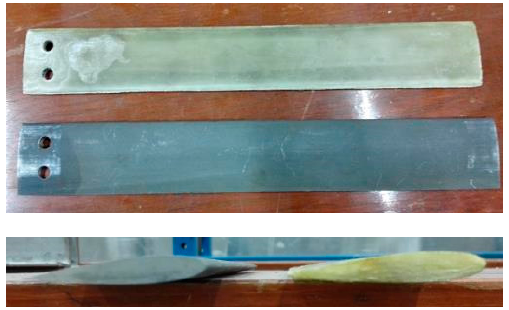
Figure 4. Geometry of rotor blade, including different materials.